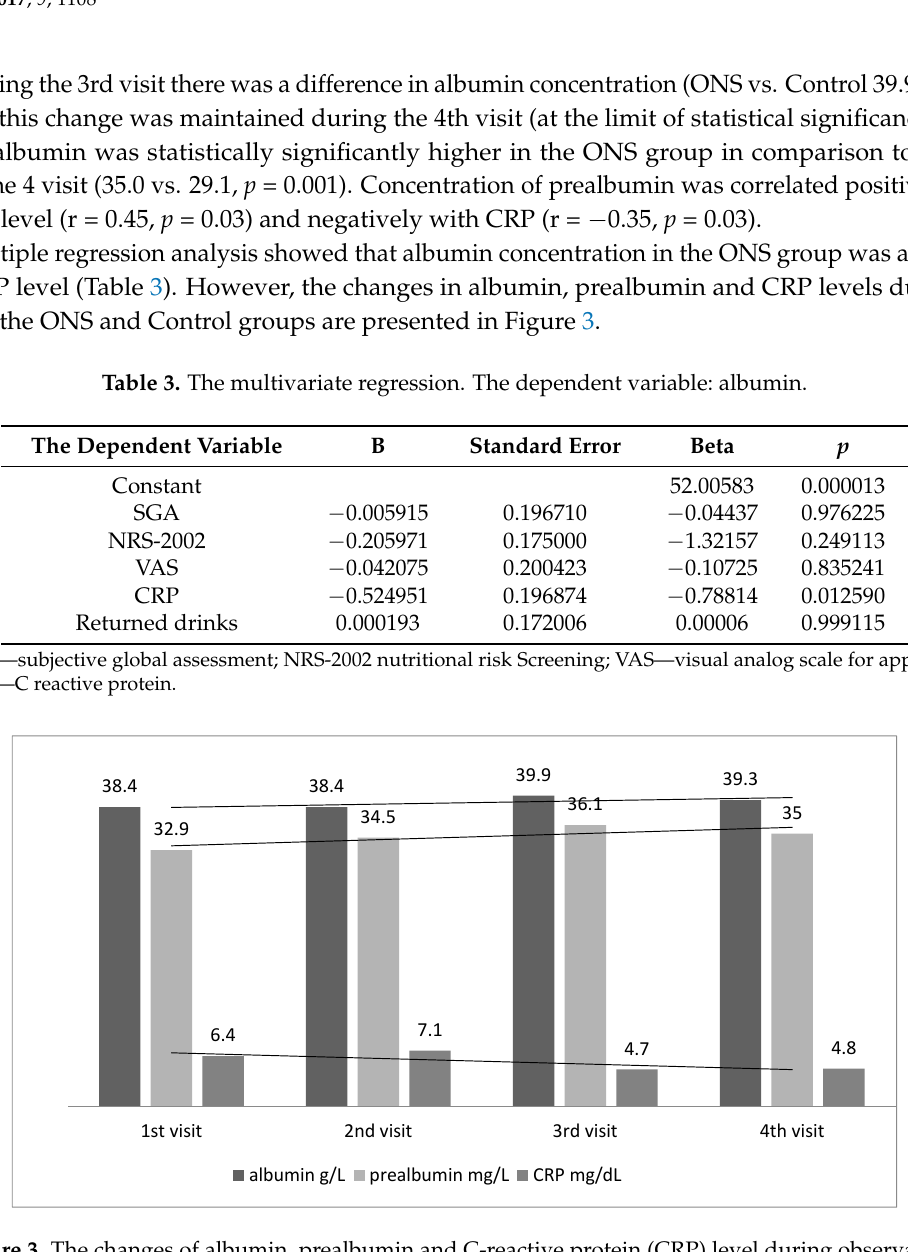
Figure 3. The changes of albumin, prealbumin and C-reactive protein (CRP) level during observation in ONS group (1—1st visit, 2—2nd, 3—3rd and 4th visit).